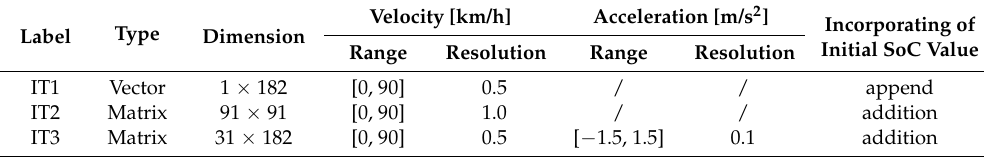
Table 1. Description of IT1, IT2 and IT3 input